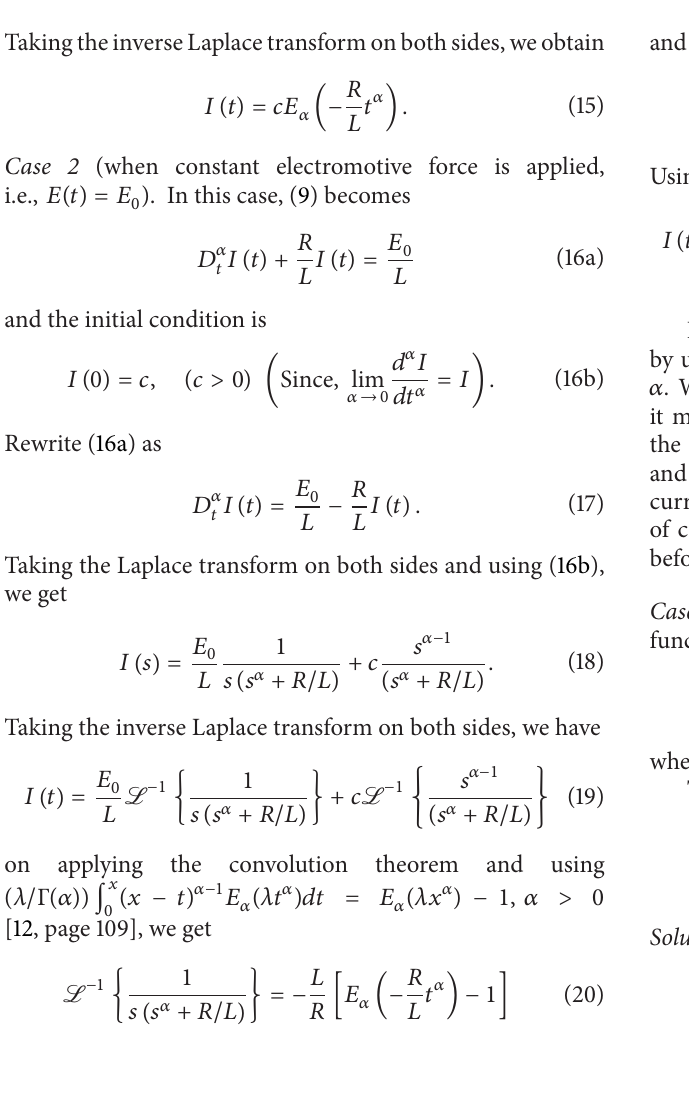
Figure 2: Time 𝑡 v/s current 𝐼